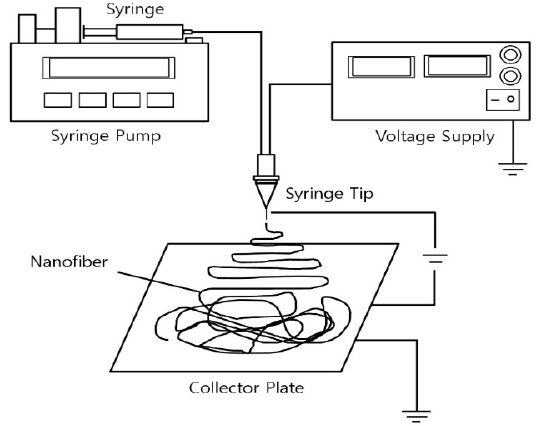
Figure 1. Schematic diagram of the electrospinning method. Table 1. Experimental conditions to produce PAN (polyacrylonitrile) nanofibers by the electrospinning method.